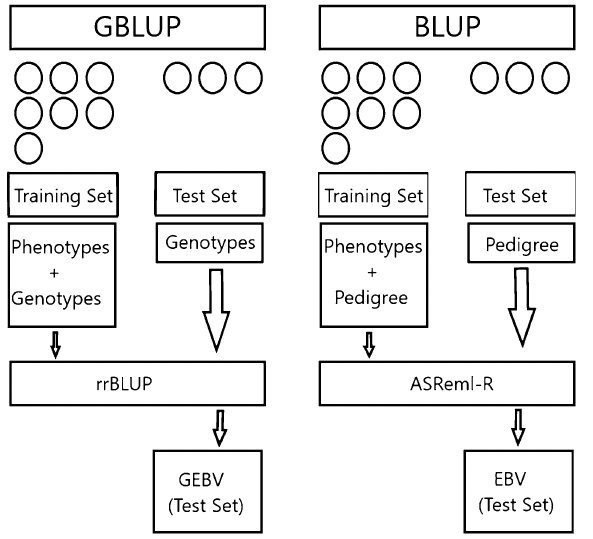
Figure 1. A diagram illustrating how GEBVs and EBVs are calculated where the phenotypic values are unavailable for the selection